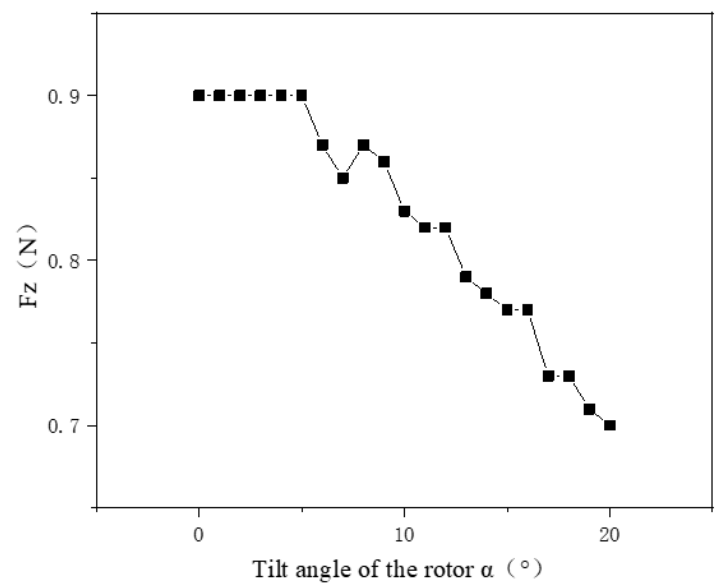
Figure 7. The comprehensive force of the stator to the rotor along z axis in different deflection angles.